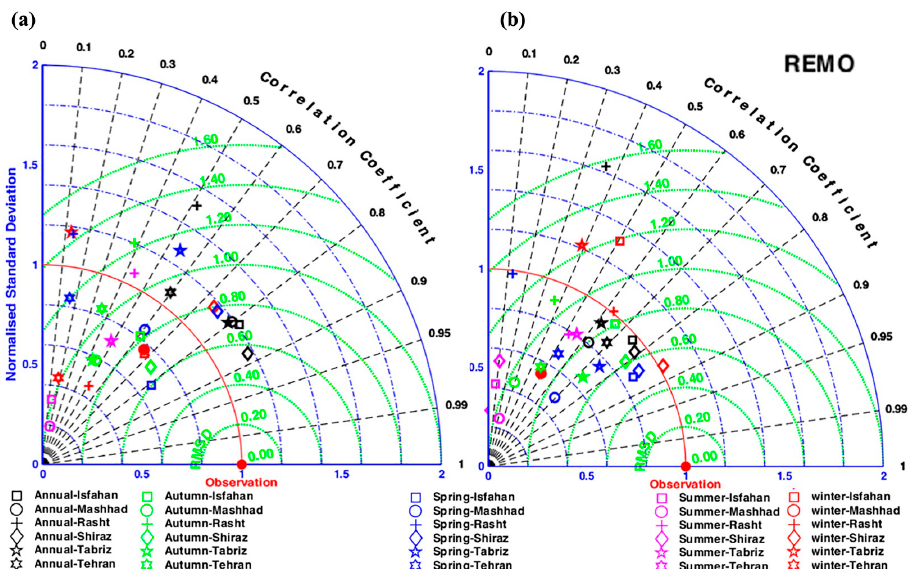
Figure 9. Taylor diagrams showing temporal correlation, RMSD and normalised standard deviation comparing ALARO-0 ( a ) and REMO ( b ) for annual and seasonal relative humidity over six studied stations during 1980–2017.